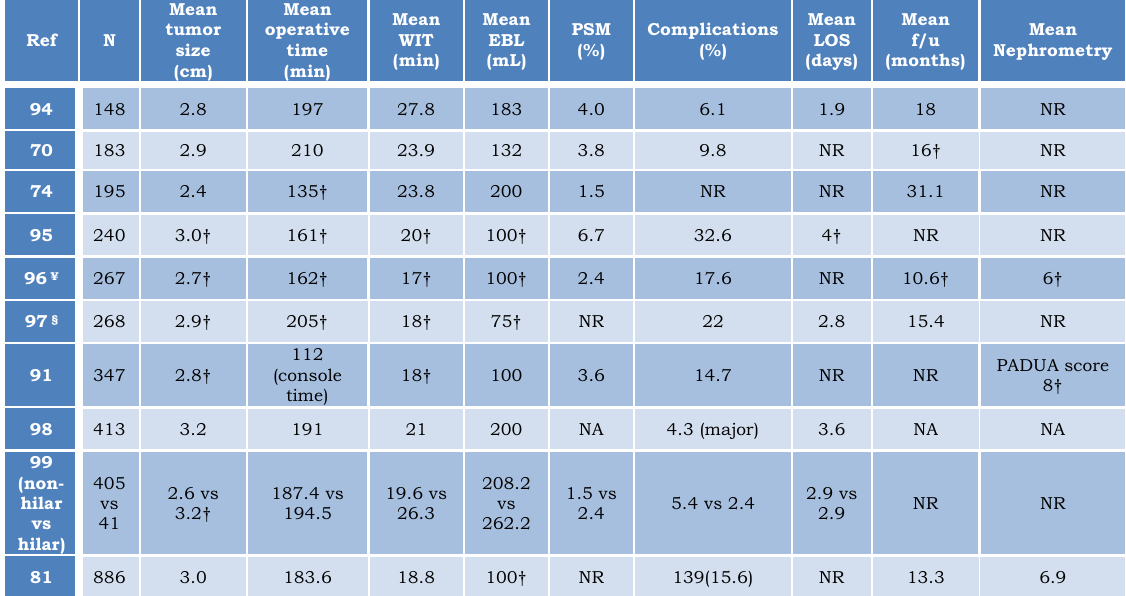
Table 1 . Ten largest robotic partial nephrectomy series* Mean Ref N